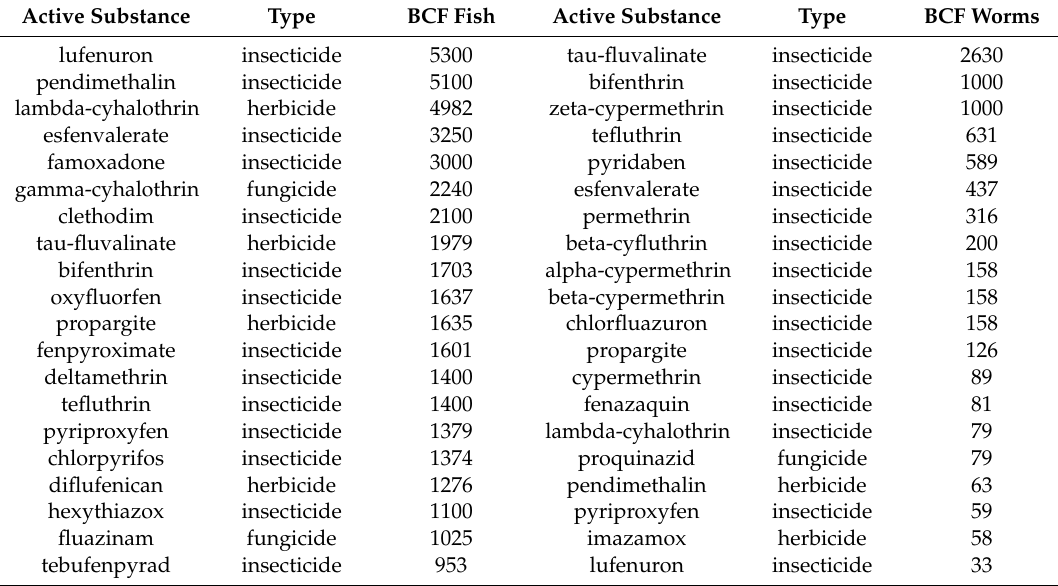
Table 3. Rating of the pesticide bioconcentration in fish and